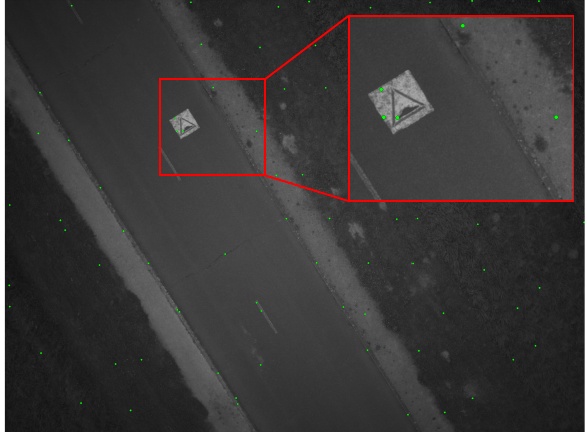
Figure 6. Features detected by FAST algorithm in the first image. The threshold choosen here is 15. The number of blocks of grid is fixed to 10 × 10 . The resolution of image is 2560 × 1920 pixels.